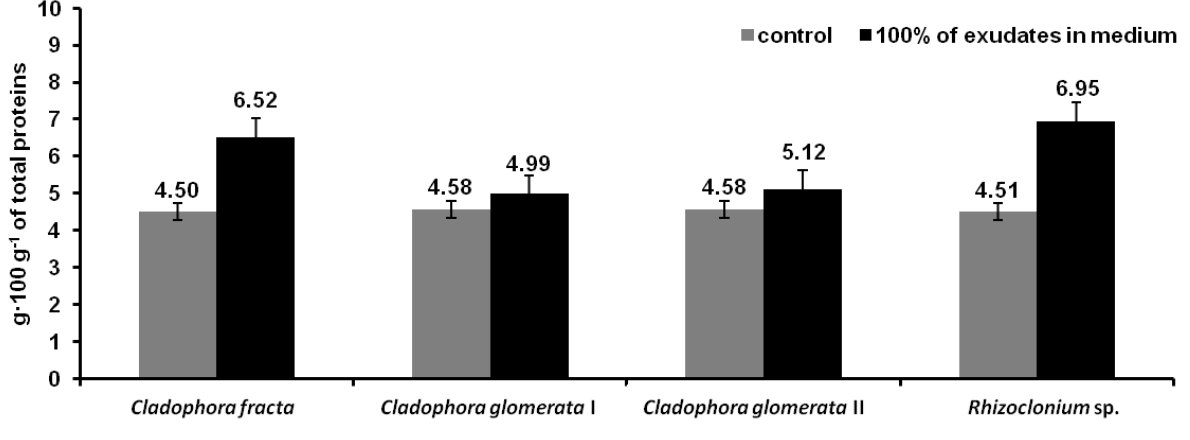
Figure 4: Diagram of Proline concentration in algae cell in control and in medium with 100% of exudates ( C. fracta with 100% of C. glomerata exudates, C. glomerata I with 100% of exudates of C. fracta , C. glomerata II with 100% of exudates of Rhizoclonium sp. and Rhizoclonium sp. with 100% of C. glomerata